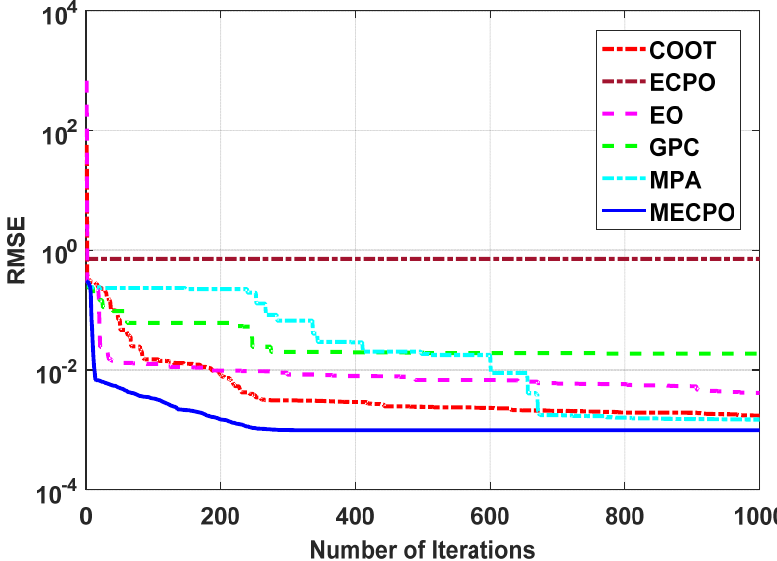
Figure 8. Convergence curve of the MECPO and other recent algorithms for the SDM.